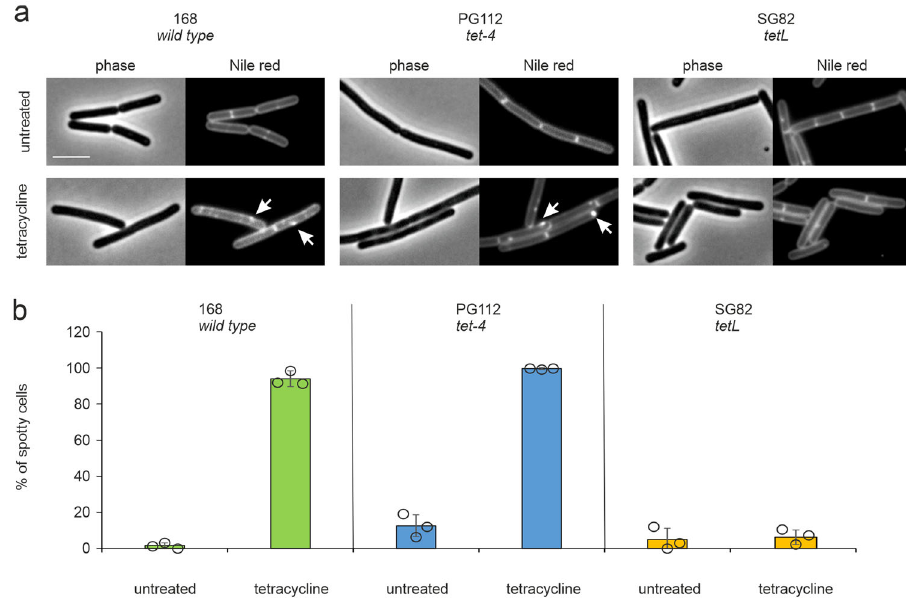
Fig. 6 Tetracycline affects the membrane independently of ribosome inhibition. Strain PG112 carries the tet-4 mutation, a point mutation in the ribosomal protein S10 that renders ribosomes insensitive to tetracycline. Strain SG82 carries the tetL tetracycline ef fl ux pump. Cells were treated with 1x MIC of tetracycline (16 µ g/ml for PG112, 100 µ g/ml for SG82) for 30 min prior to membrane staining with Nile red and microscopy. See Supplementary Fig. 18 for titration of tetracycline concentrations. a Microscopy images of Nile red-stained cells. Scale bar 2 µ m. b Quanti fi cation of microscopy images showing the percentage of spotty ( = membrane-stressed) cells. Quanti fi cation was done manually. Sample size was ≥ 100 individual cells per condition. Error bars show standard deviation of the mean from three replicate experiments. Circles indicate individual